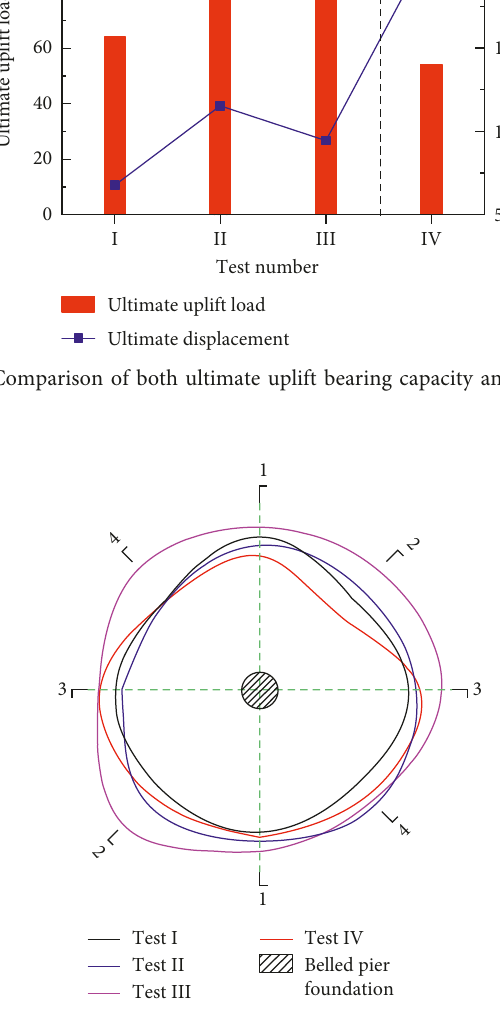
Figure 10: Planar projection of the failure